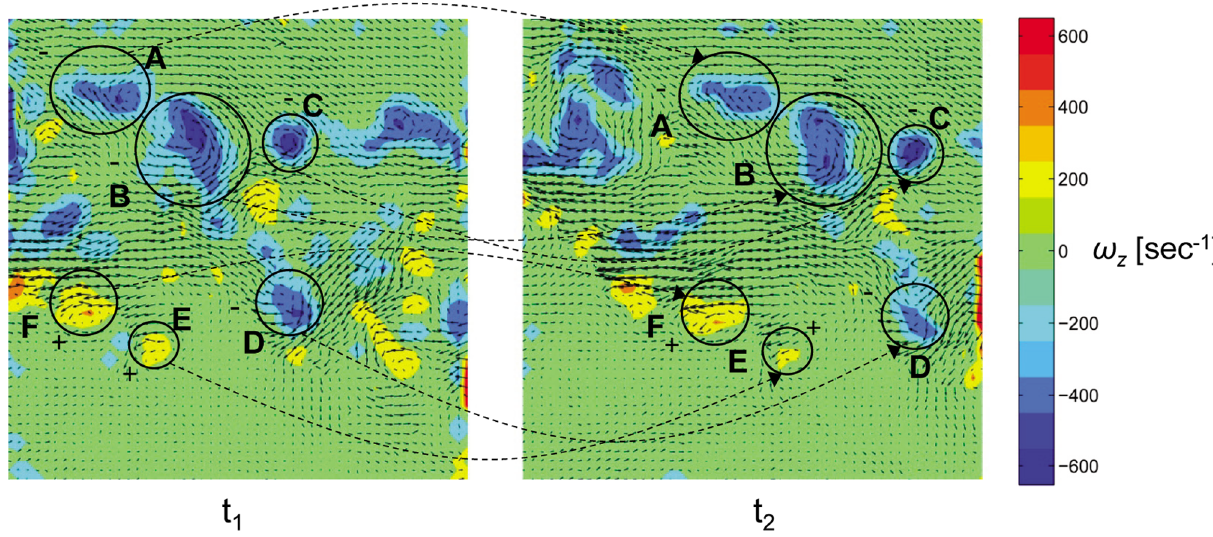
Figure 7. Two consecutive spanwise vorticity fields (t 2 =t 1 + 2 msec). The air flows from left to right and each frame size is 9 6 9 cm 2 .